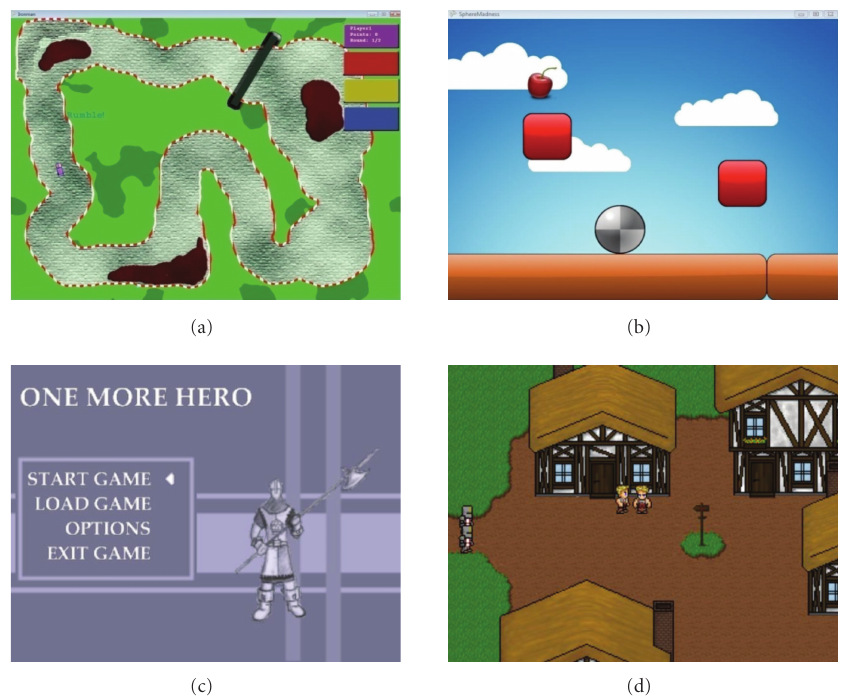
Figure 3: Game based on XNA framework (Top left: Racing; Top right: Codename Gordon; Bottom: